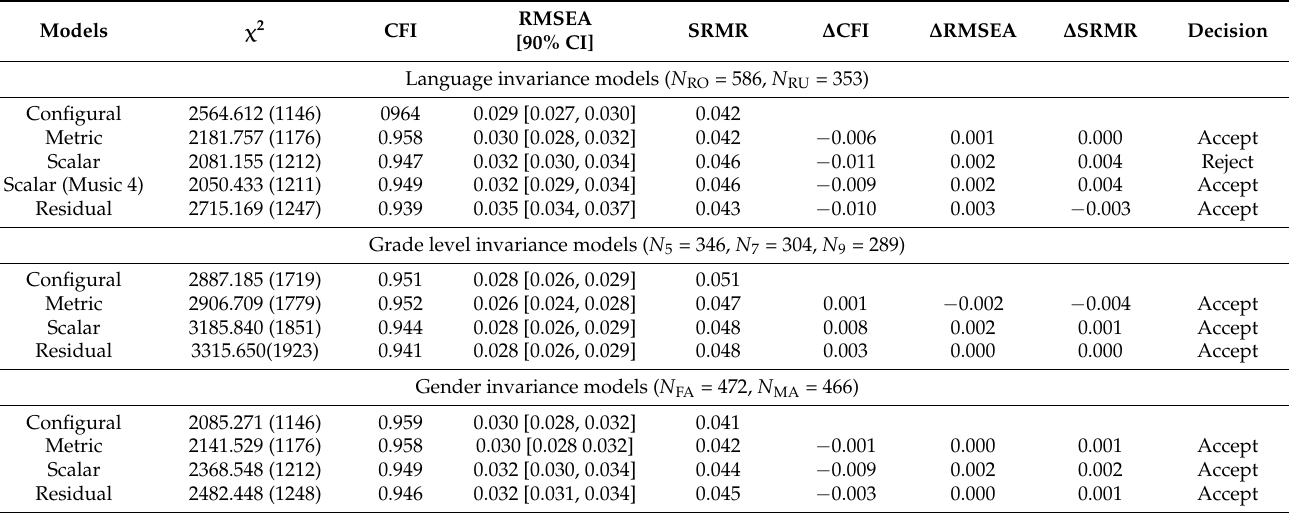
Table 8. Measurement invariance models by language, grade, and gender. Models